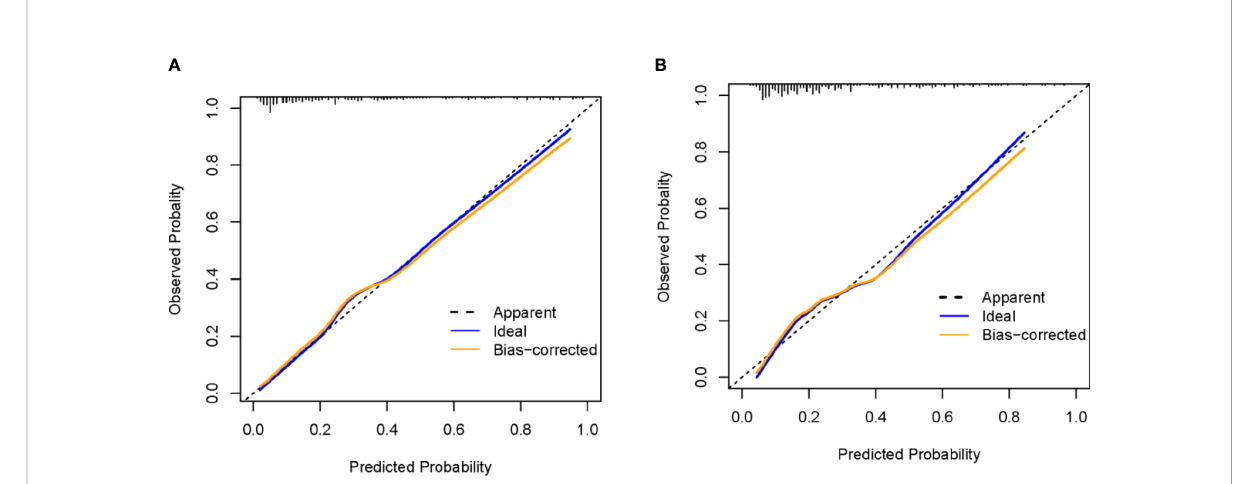
FIGURE 4 The calibration curve of the aGAPSS-IS score in the training and the validation cohort. (A) mean absolute error = 0.015 (training cohort); (B) mean absolute error = 0.028 (validation